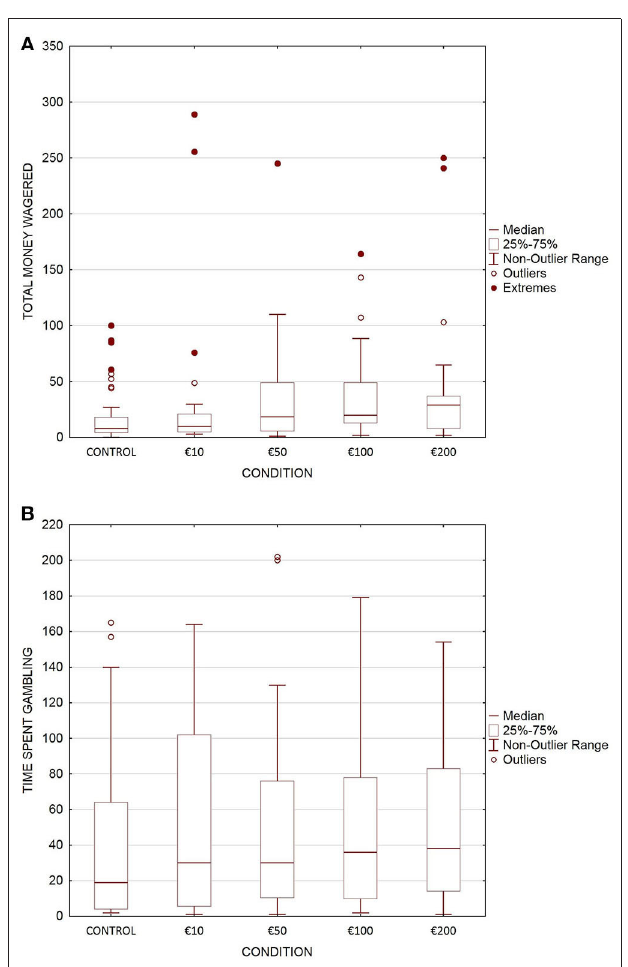
FIGURE 1 | Box plots of total money wagered (A) and time spent gambling (B) during the experimental gambling session, according to the condition.